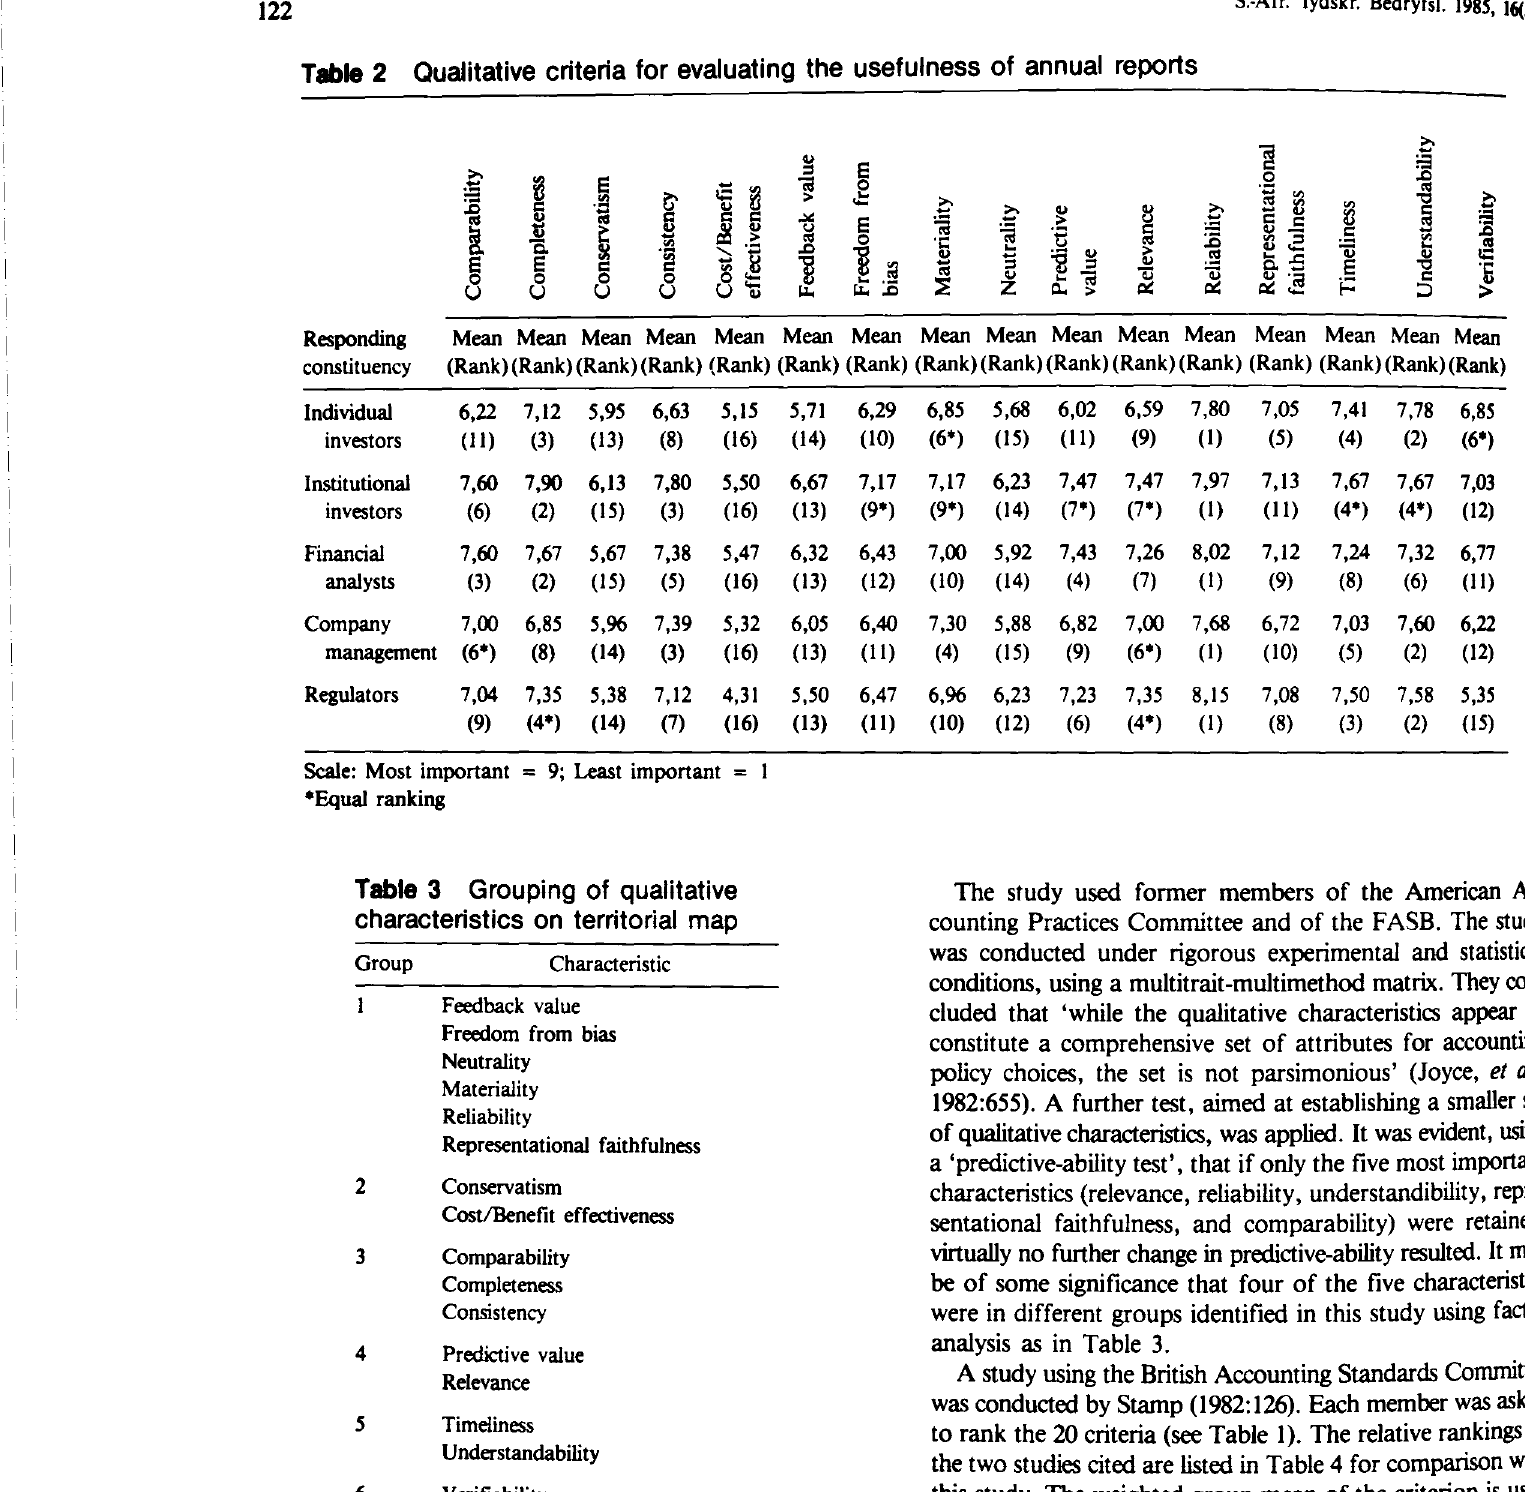
Grouping of qualitative characteristics on territorial